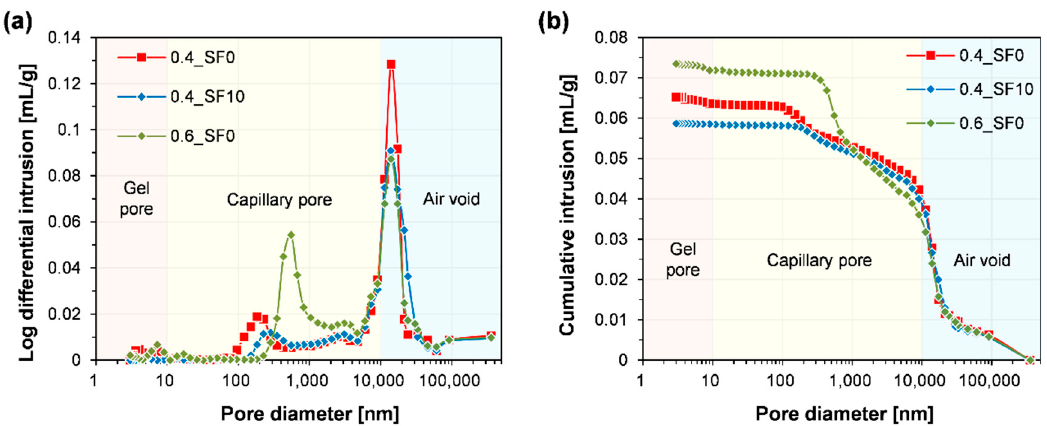
Figure 4. Pore size distribution of air lime mortars at 91 days: ( a ) log differential intrution and ( b ) cumulative pore volume. The size ranges of the gel pores, capillary pores, and air voids were determined according to previous studies [46,47].